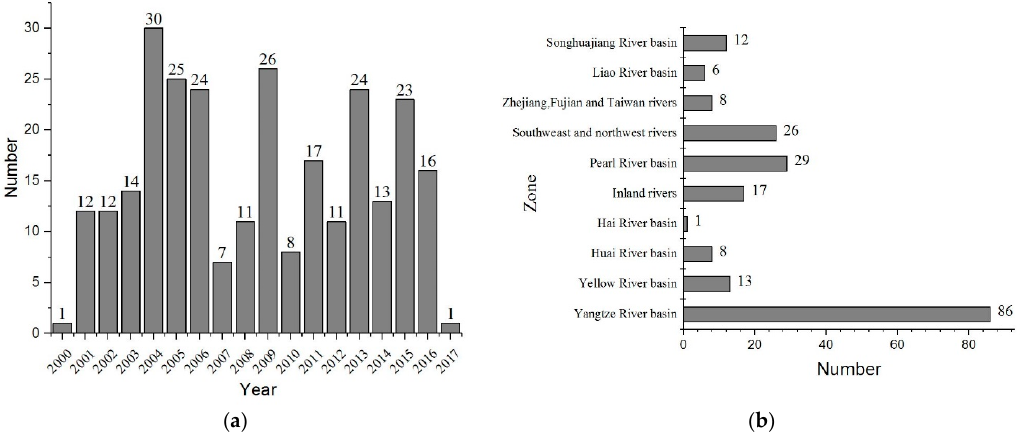
Figure 2. ( a ) Temporal distributions of water storage and hydropower projects; ( b ) spatial distributions of water storage and hydropower projects.